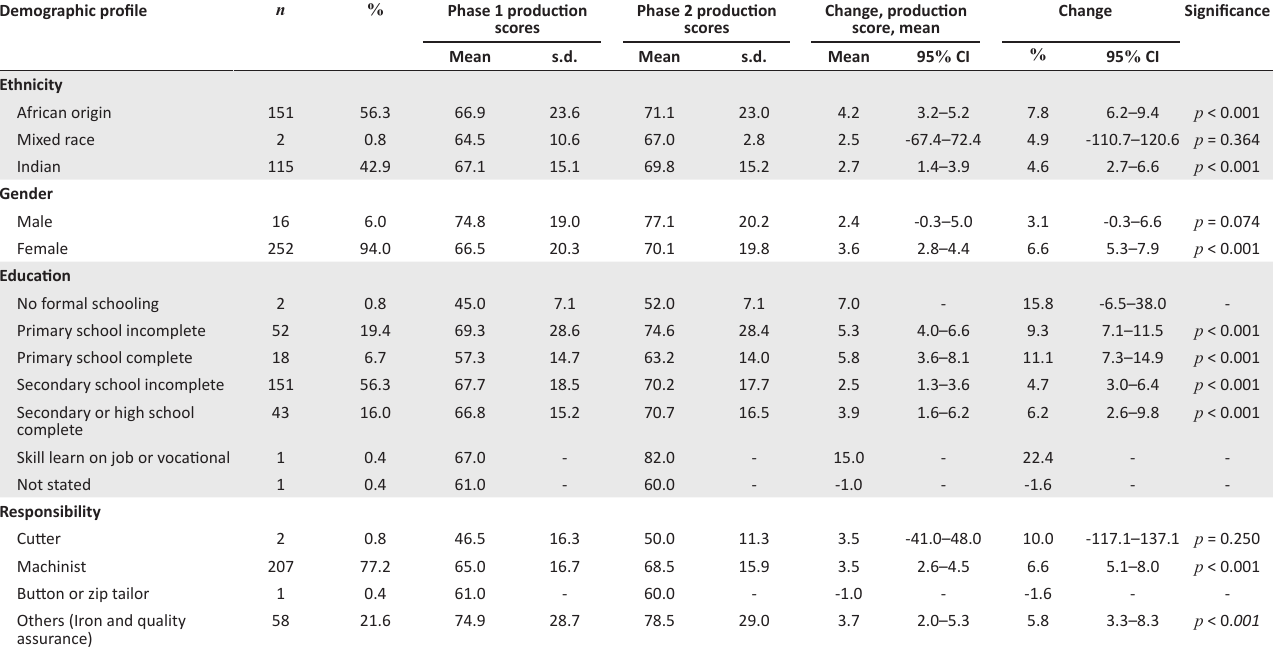
TABLE 1: Mean production scores in Phases 1 and 2 and changes in production scores with correction for presbyopia. Demographic